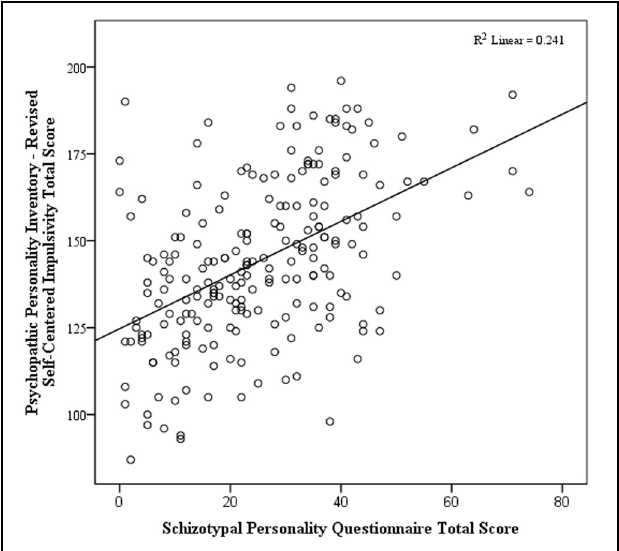
FIGURE 1 | Scatterplot of total schizotypy and self-centered impulsivity.